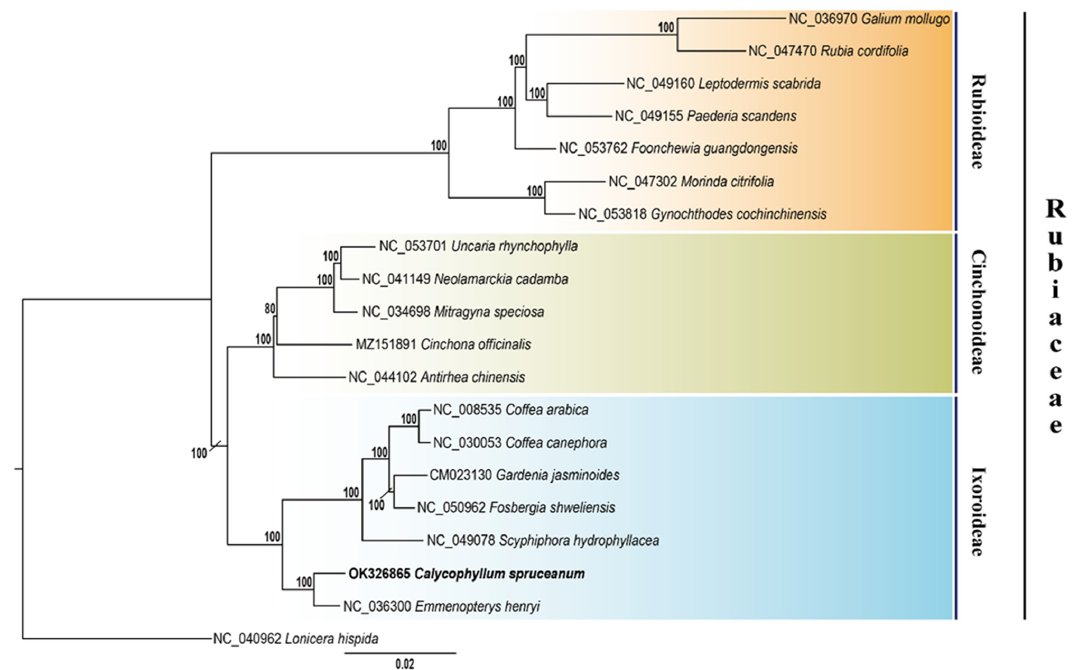
Figure 4. The maximum likelihood (ML) phylogenetic tree of the Rubiaceae family based on chloroplast genome sequences. Values along branches correspond to bootstrap percentages. The position of capirona ( C. spruceanum ) is indicated in black text. Lonicera hispida was set as the outgroup .